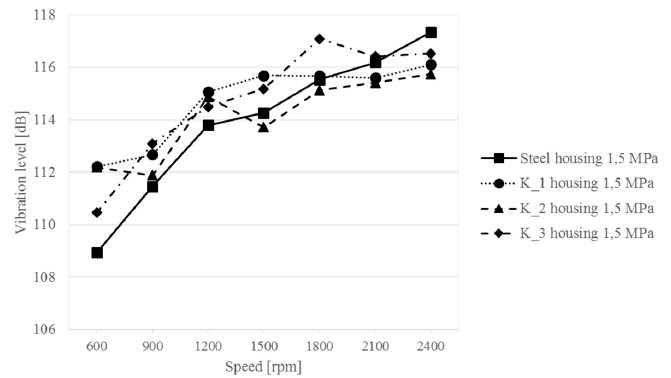
Figure 8. Changes in the vibration level of the upper gearbox plate at different rotational speeds of the gear—1.5 MPa load.